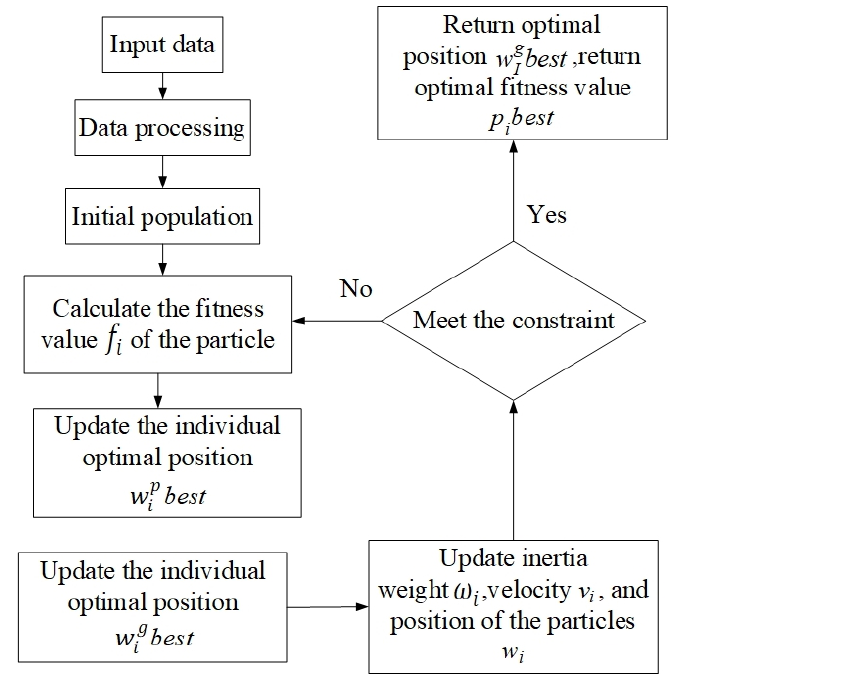
Figure 3. The structure of the PSO algorithm.